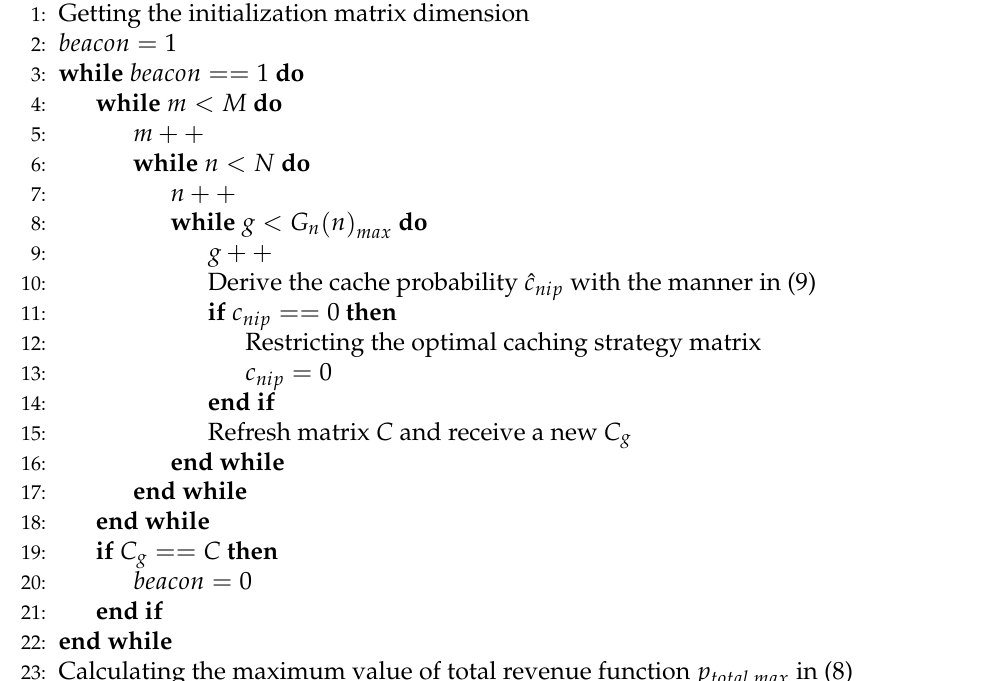
Algorithm 1 Edge caching strategy based on mobile speed and